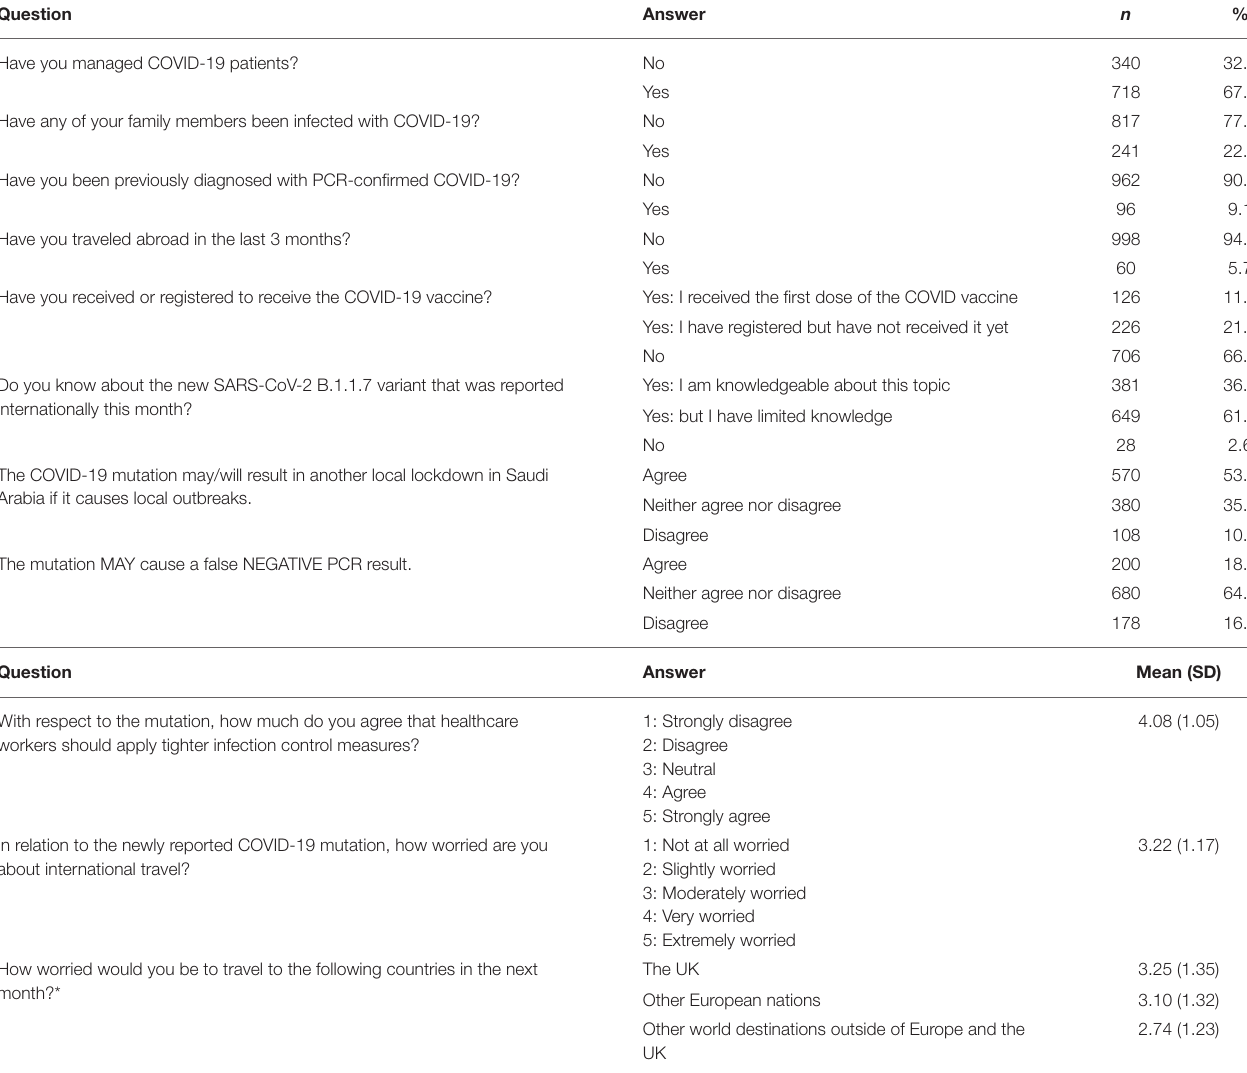
TABLE 2 | HCWs’ perceptions and experiences of the COVID-19 pandemic and its mutations. Question Answer n % Have you managed COVID-19